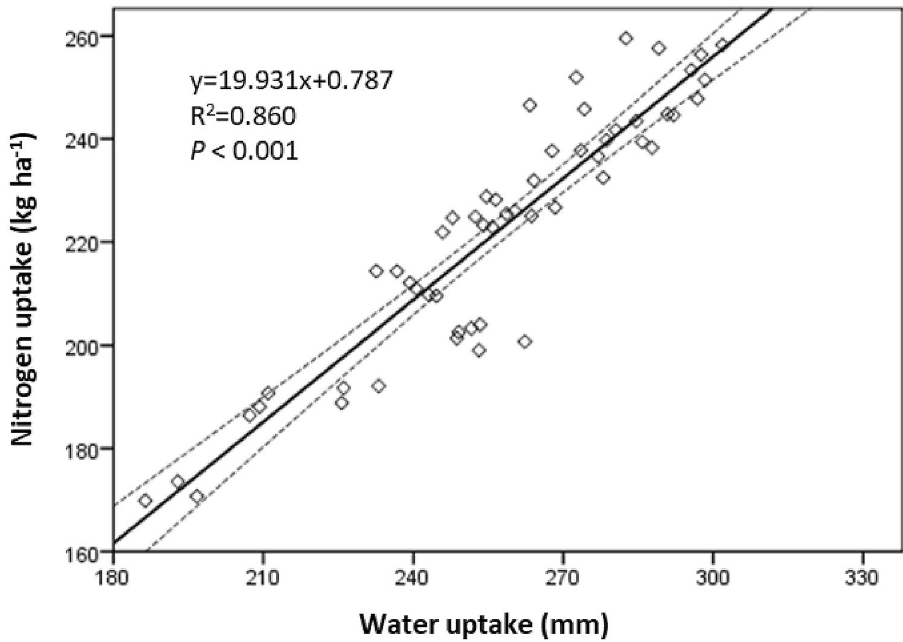
Figure 5. The relationship between water uptake and nitrogen uptake of spring wheat during the growing season in 2016–2018. The solid line and medium dash lines indicate the regression line and 95% confidence intervals.